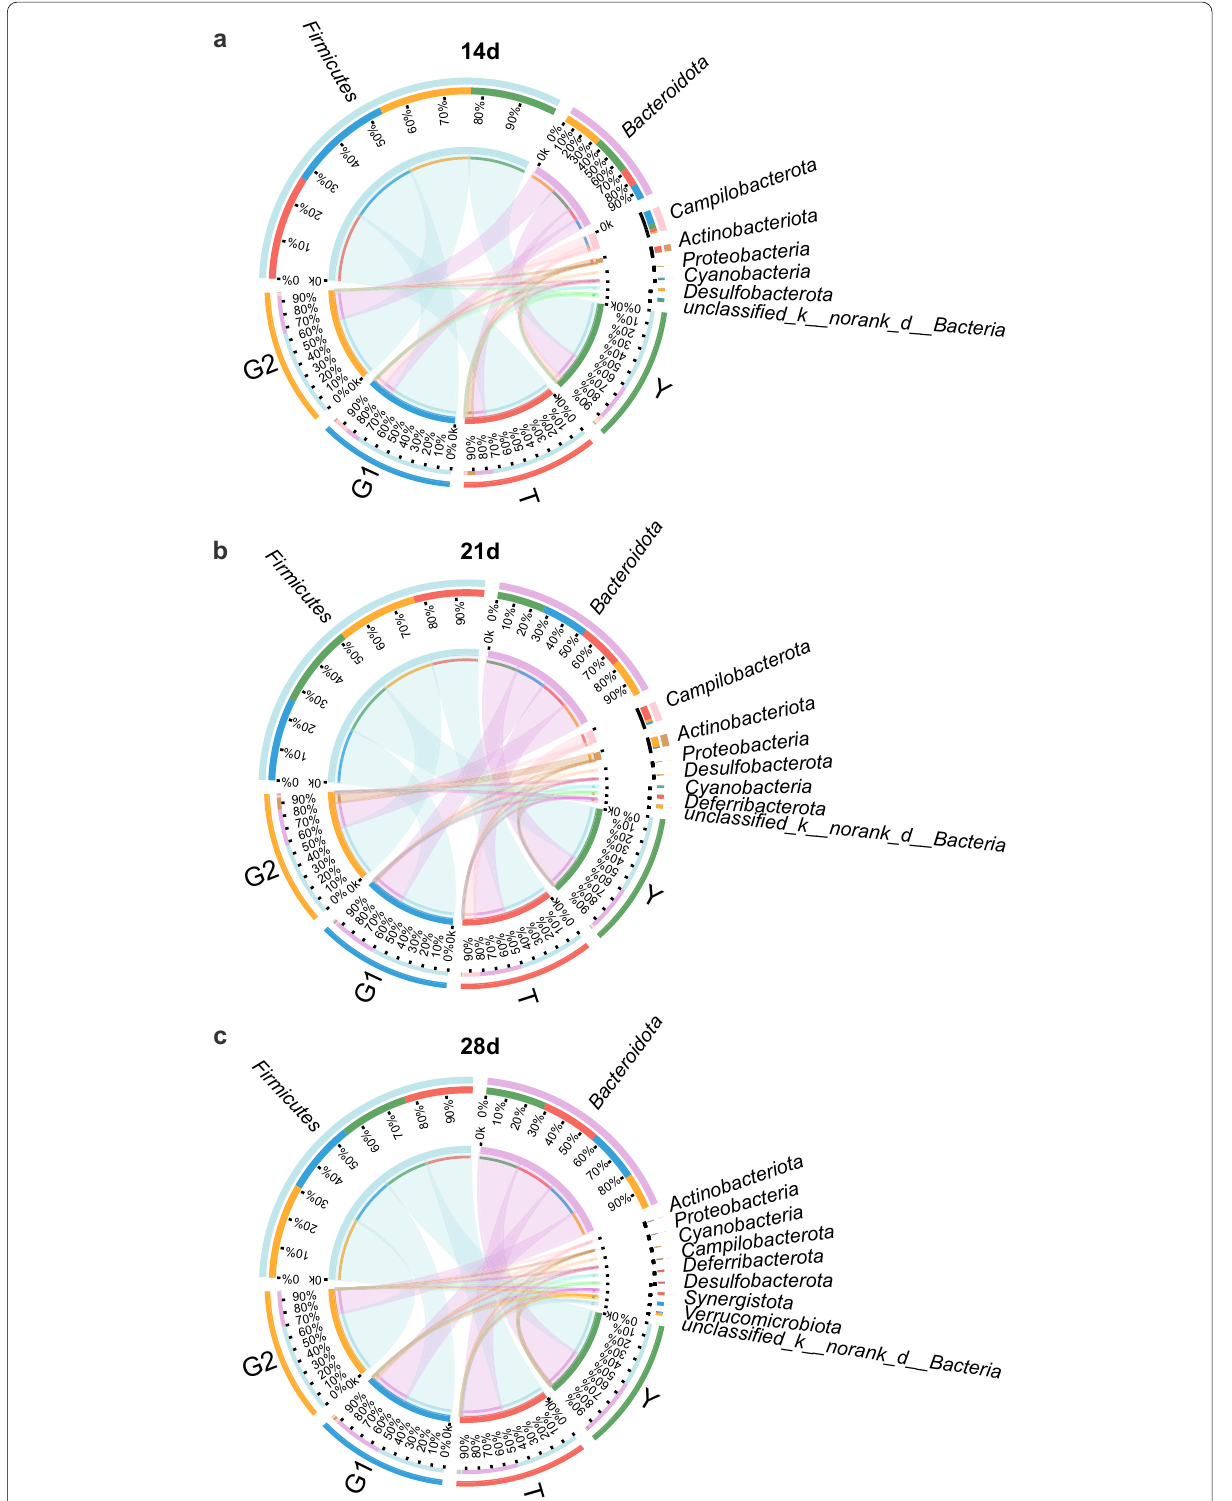
Fig. 6 Bacterial communities in the cecum of broilers aged 14 days a , 21 days b and 28 days c at phylum level in groups Y (control group), T (antibiotic group), G1 (0.1% β-1,3/1,6-glucan), and G2 (0.2% β-1,3/1,6-glucan). The cecum microbial community structure between the Y, T, and G1, and G2 groups were differentiated by colors (green, red, blue, orange,